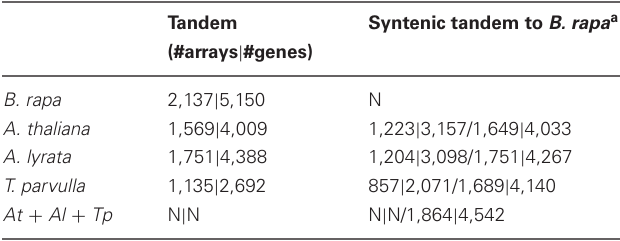
Table 2 | Syntenic tandem genes between B. rapa and A. thaliana , A. lyrata , or T. parvulla